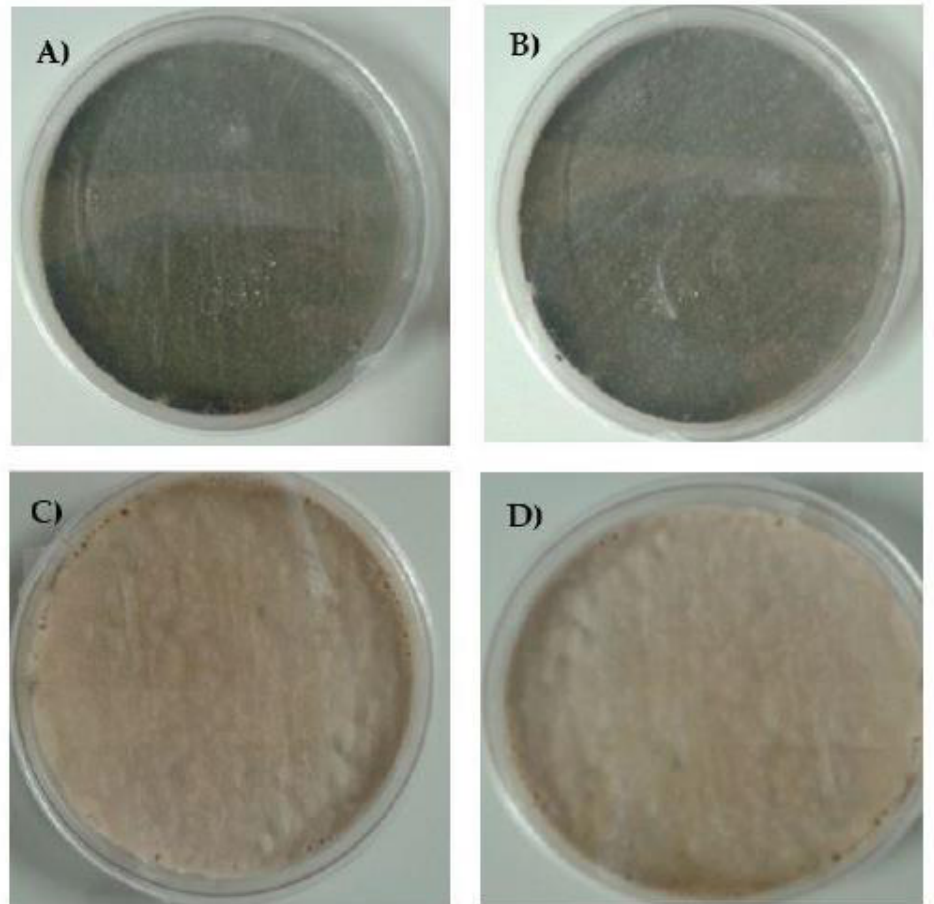
Figure 2. Growth of A. fumigatus isolates on ( A ) Sabouraud (SAB), and SAB with addition of ( B ) voriconazole (VOR), ( C ) itraconazole (ITR) and ( D ) posaconazole (POS) after the 1st passage.